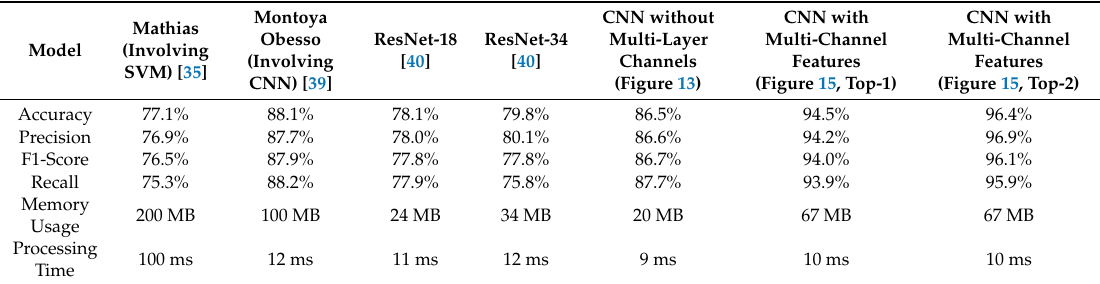
Table 3. Comparison of our novel model’s performance with that of several other state-of-the-art classifier models published in previous / recent works from the relevant